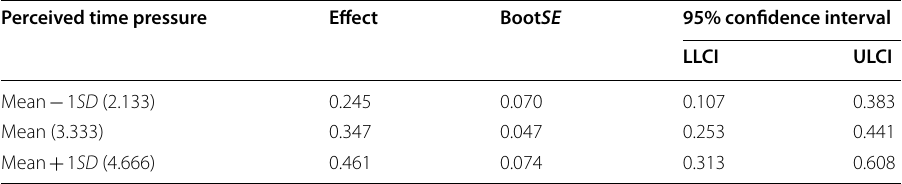
Table 5 Conditional effects of social interaction atmosphere on excitement at different levels of perceived time